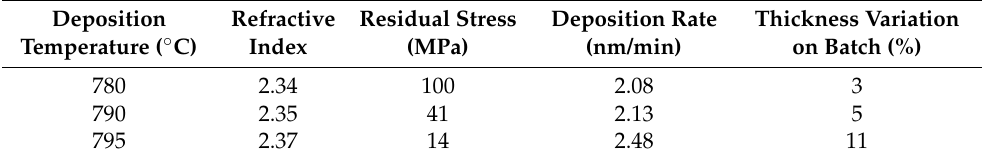
Table 1. Silicon-rich silicon nitride properties and deposition rate as a function of deposition temper-